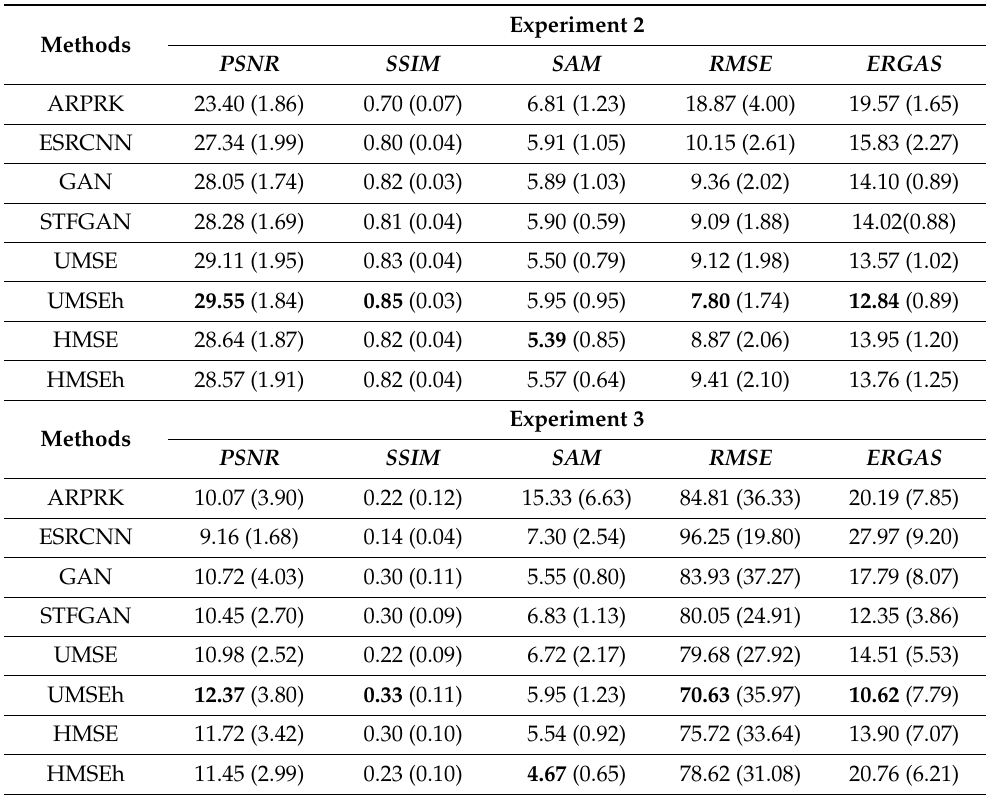
Table 4. Results of Experiment 2 (Landsat-8 and Sentinel fusion) and Experiment 3 (Sentinel and NAIP fusion). Results are averages of 20 testing images. Bold value indicates the best performance metric of a certain